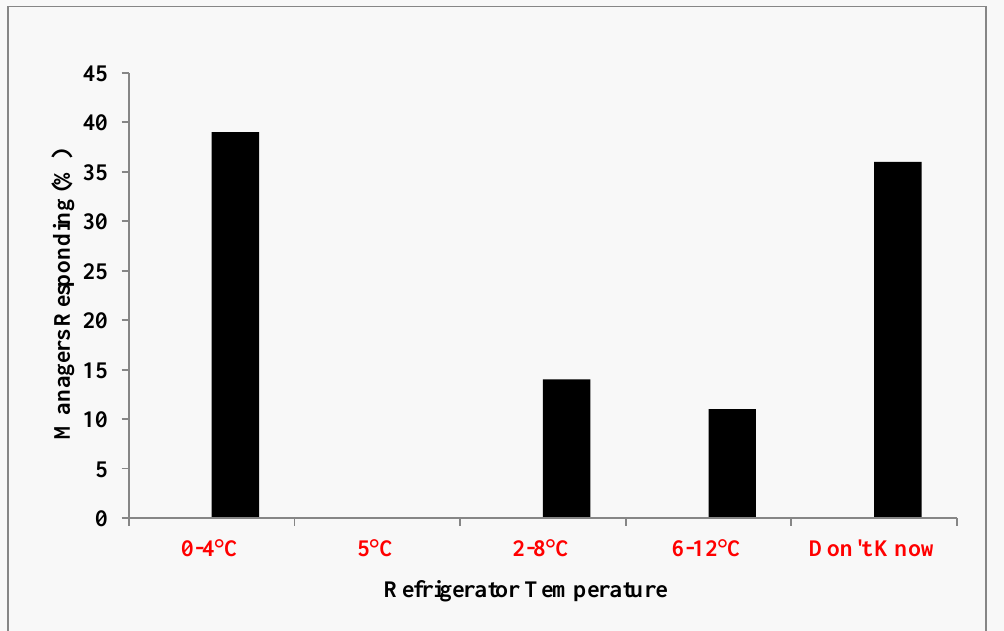
Figure 3. Knowledge of Ideal Refrigerator